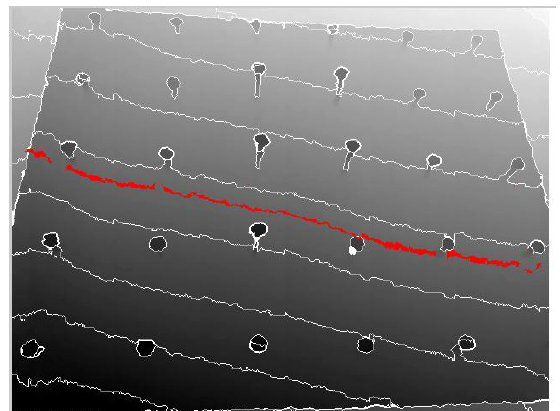
Figure 5. Range Contour of a planar surface. Thick red line with 3 to 5 pixels width is representations of deficiency in distance distinction (Image: Kinect camera calibration field).